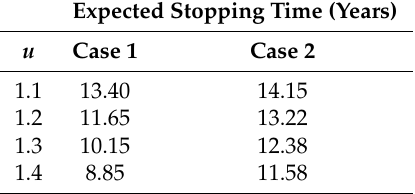
Table 5. Expected stopping times by frailty factor u for case 1 and case 2 agents aged 65, in the healthy state, and with total wealth of 10 Y —and other parameters as given in Table 1. Increasing frailty results in shorter stopping times, as less healthy agents choose the safer retirement village world sooner. The situation illustrated is for agents with risk aversion of γ = − 0.5, where case 2 agents are less conservative than case 1 agents. With more risk averse agents, this boldness of agents with bequest motives over those without is